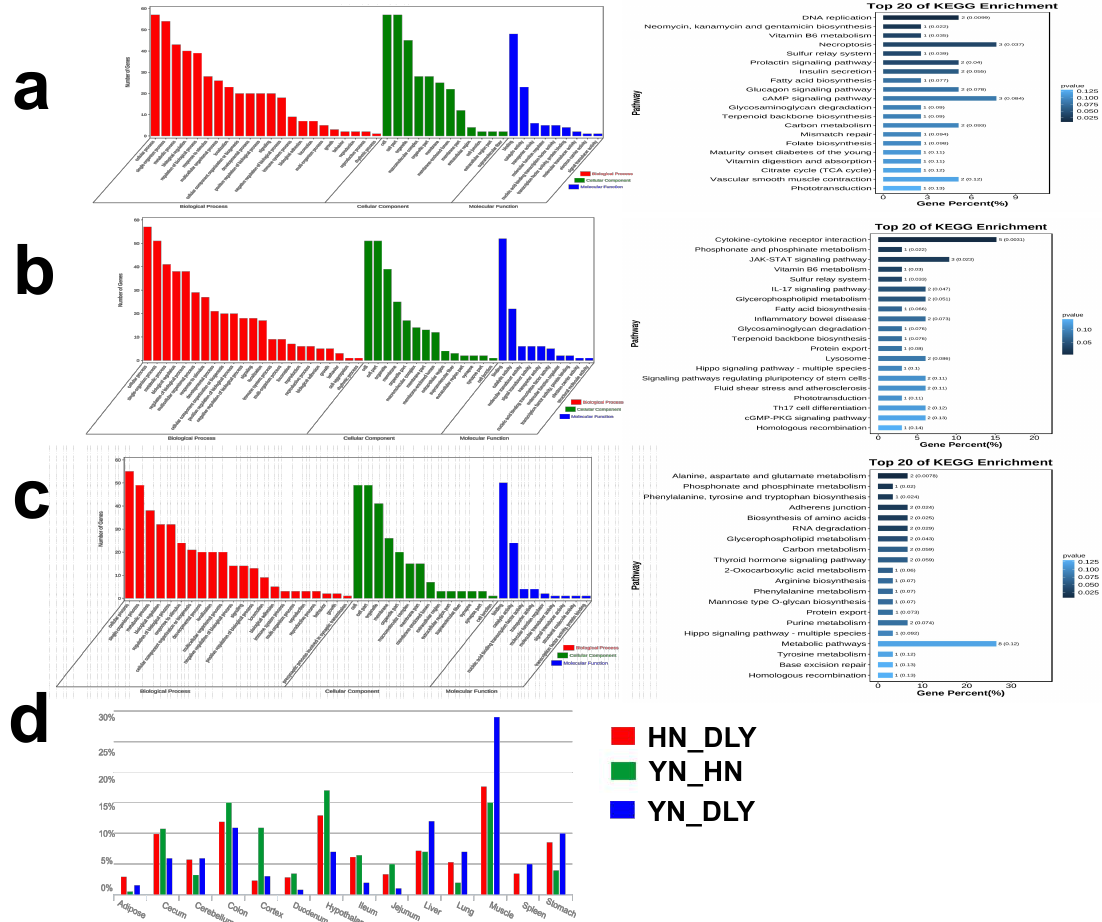
Figure 4. The function analysis of the selected genes. ( a ) KEGG pathway and top 20 GO enrichment analysis of differential expressed genes in YN-DLY group. ( b ) KEGG pathway and top 20 GO enrichment analysis of differential expressed genes in HN-DLY group. ( c ) KEGG pathway and top 20 GO enrichment analysis of differential expressed genes in YN-HN group. ( d ) Annotation of the non-coding selection regions with 14 tissues promoter